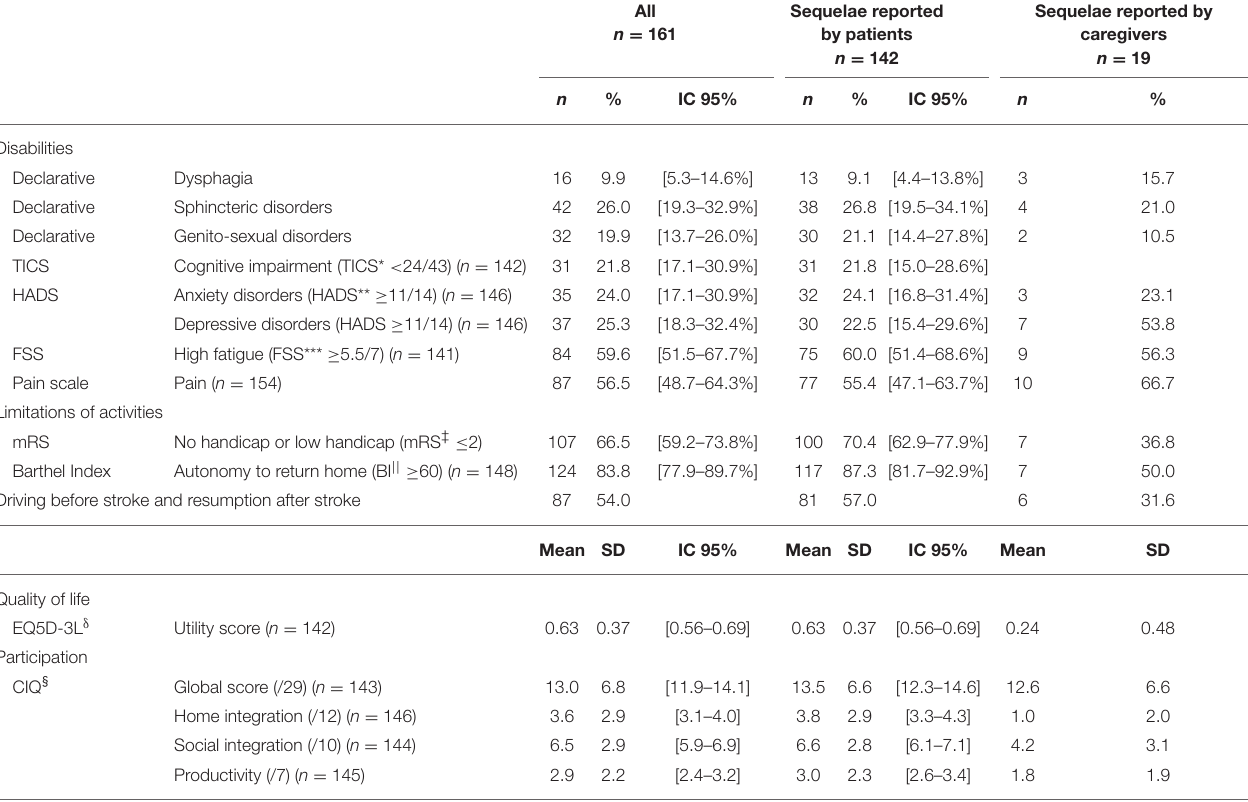
TABLE 2 | Frequency of 1 year post-stroke sequelae and quality of life of study sample.